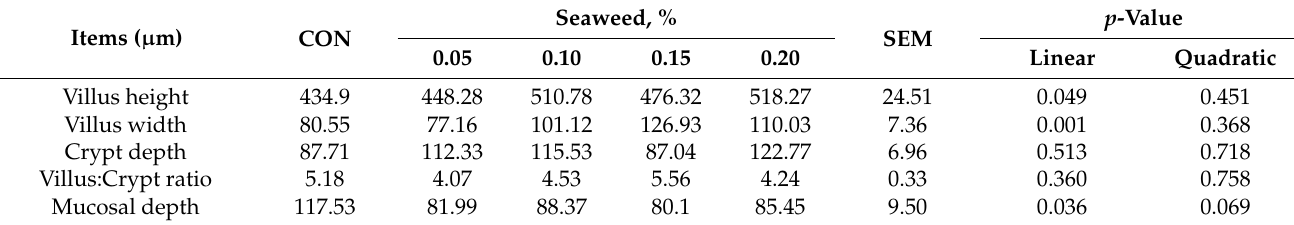
Table 8. The effect of dietary red seaweed supplementation on small intestinal morphology in broilers 1 .